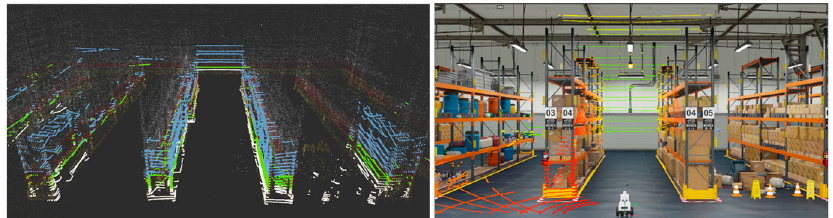
Figure 4. ( Left ) multi-layered scan measurement overlapped on the 3D point-cloud map of the full warehouse in ROS 3D visualization tool of RViz, ( right ) multi-layered 3D NDT scan-matching scene in Isaac Sim.